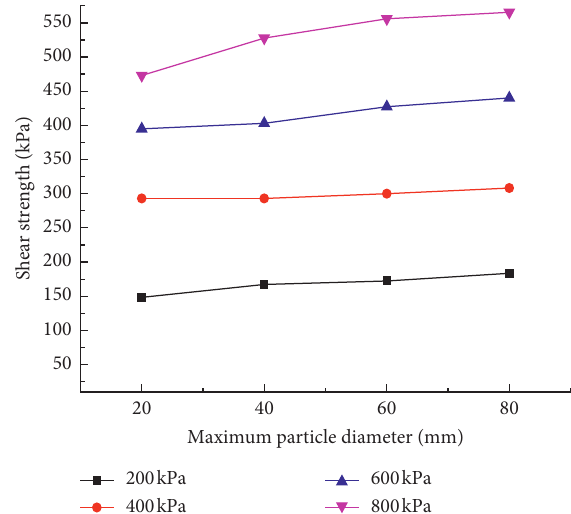
Figure 7: Shear strength with different maximum particle diameters.